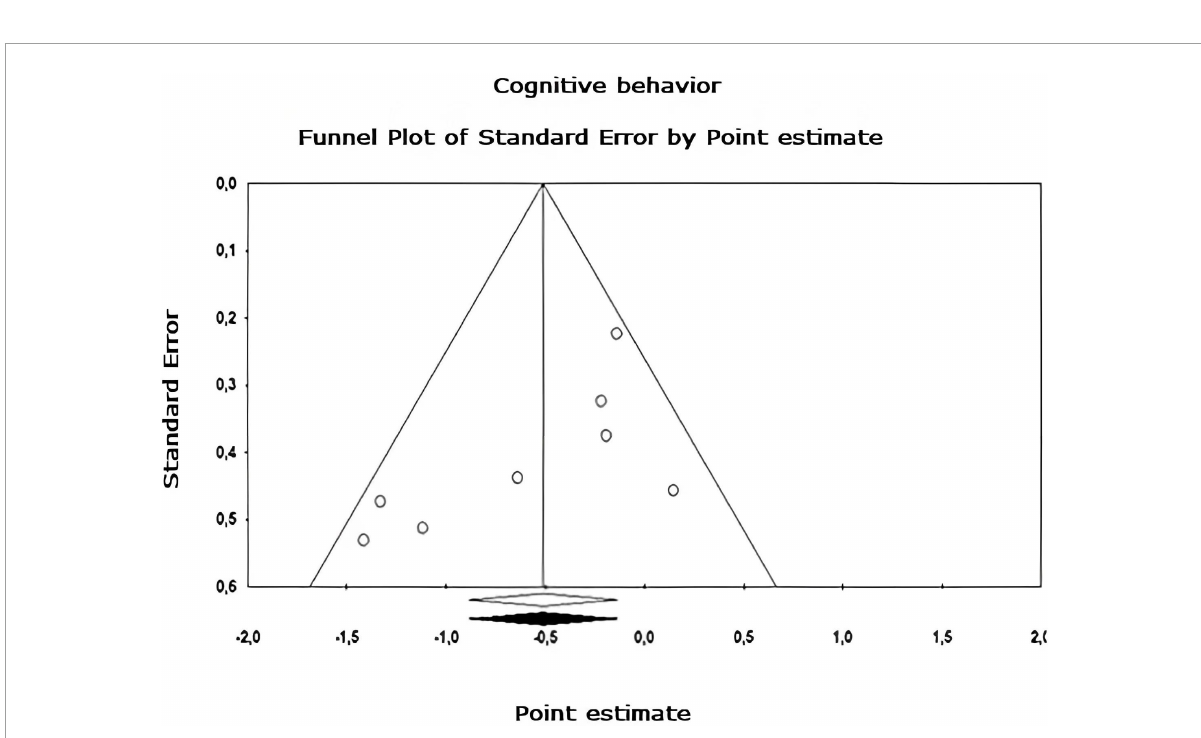
FIGURE9 Funnel plot of publication bias for the cognitive behavior sub-metaanalysis, created using the Trim and Fill method (Duval and Tweedie, 2000). It shows an estimate of the effect sizes of all UAs. Data obtained from the experiments are shown in white. No data points were